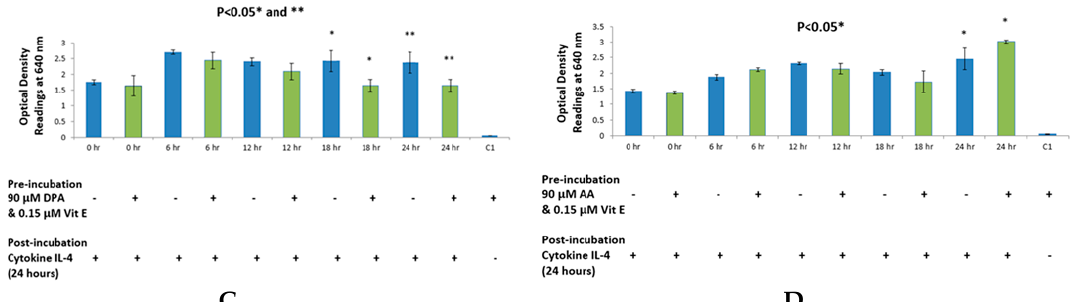
Figure 3. HEK-Blue detection assay with 90 μ M of omega-3 and omega-6 fatty acids with 0.15 μ M vitamin E using cytokine IL-4 as the bioactive agent. ( A – C ) depict a time-dependent inhibition of SEAP secretion from HEK-Blue cells when treated with DHA, EPA and DPA, respectively; ( D ) shows an increase in SEAP secretion from HEK-Blue cells when treated with AA at the 24-h time point. * p < 0.05, ** p < 0.05 denotes significance of optical density readings compared to positive control depicted in blue colour. Control 1 (C1) depicts the optical density reading obtained when HEK-Blue cells are treated with fatty acid only, without the cytokine stimulation.